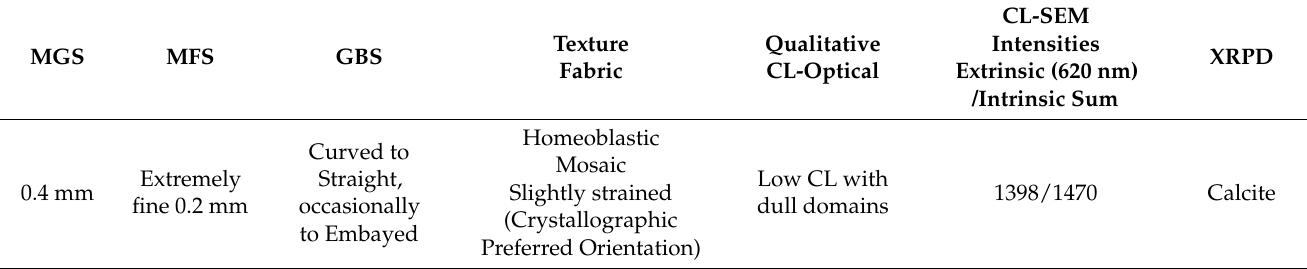
Table 1. Petrographic, Optical-CL and quantitative CL-SEM properties and mineralogical composition of sample QL.